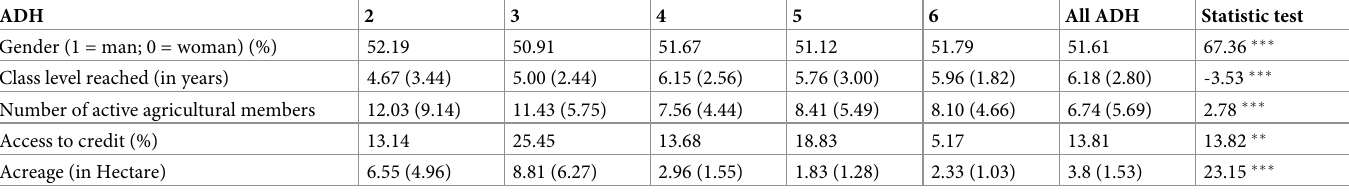
Table 4. Socio-economic and demographic